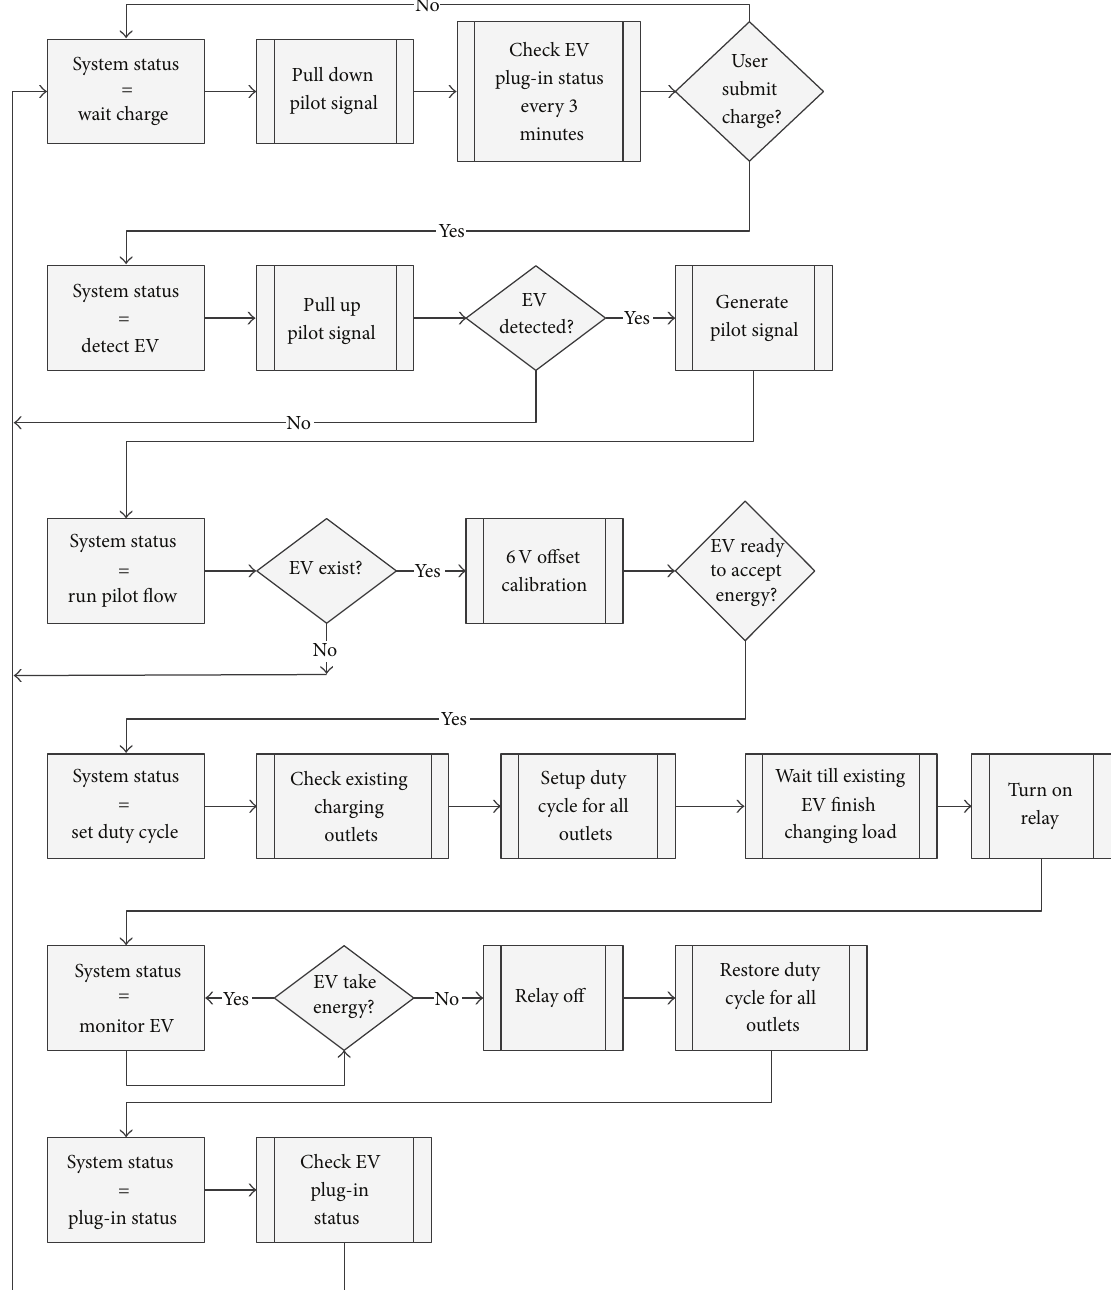
Figure 6: State machine of simple Current Sharing